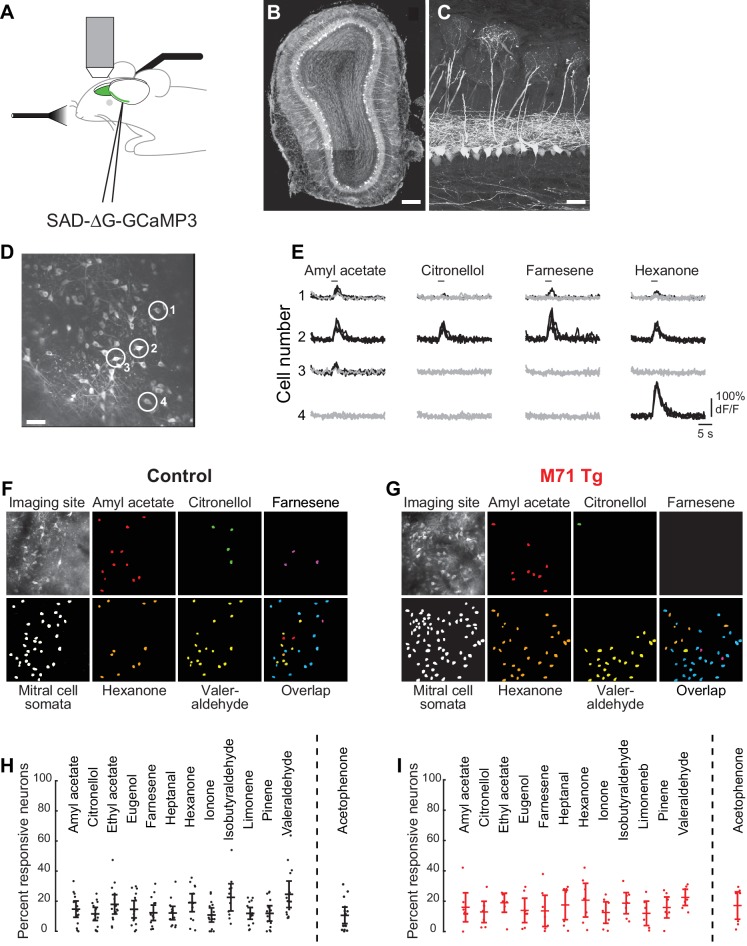
Normalization of odor-evoked mitral cell activity in M71 transgenic mice.(A–I) Two-photon in vivo imaging of mitral cell odor responses in anesthetized mice. (A) Schematic of rabies-GCaMP3 injection into the lateral olfactory tract (LOT) and two-photon imaging of olfactory bulb mitral cells. (B) Mitral cells expressing GCaMP3 in a coronal slice of the olfactory bulb after injection of rabies-GCaMP3. Note the restriction of labeled cell bodies to the mitral cell layer. Scale bar = 100 µM. (C) Higher magnification of mitral cells expressing GCaMP3 throughout the neuron, including the apical and lateral dendrites. Scale bar = 20 µM. (D) Two-photon micrograph showing GCaMP3 expression in mitral cell of a single imaging site. Scale bar = 30 µM. (E) Example traces of the responses of 4 mitral cells (circled in (D)) to 4 different odorants. Traces represent responses to 4 individual odorant exposures, non-responsive trials are shown in grey, responsive trials in black. Horizontal bar indicates odorant application. (F, G) Representative maps of odor-evoked mitral cell activity elicited by a panel of 5 different odorants at a single imaging site in a control (F) and M71 transgenic (G) mouse. Cells responding to at least 2 out of 4 trails are color-coded. Overlap: cells responsive to more than one odorant are shown in blue. (H, I) Mean fraction of cells (horizontal line) responding to a given odorant at 0.01% vol./vol. dilution, in control (H) and M71 transgenic (I) mice. Dots represent the fraction of responding cells for a given imaging site. Controls: 14 imaging sites in 7 mice, n (median number of cells per site) = 35; M71 transgenic: 7 imaging sites in 4 mice, n = 28. Error bars = 95% CI of the mean.